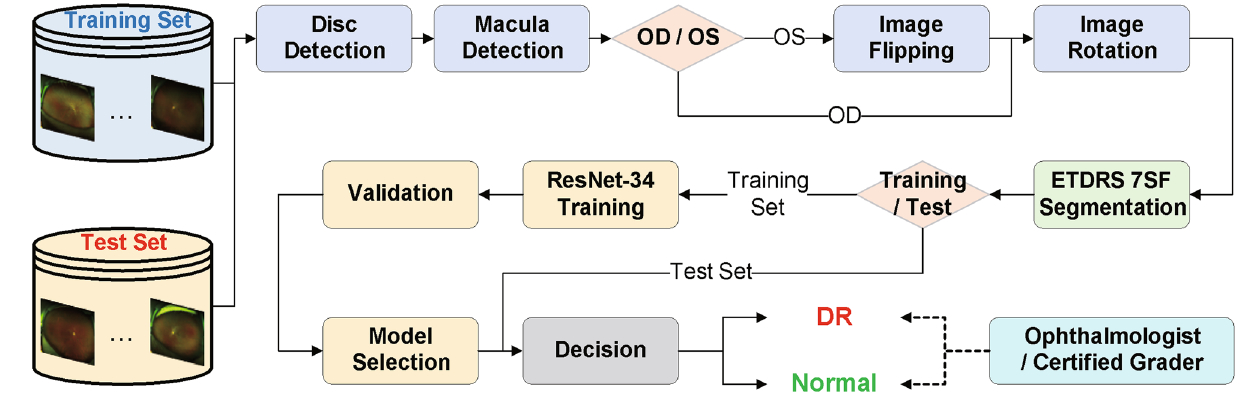
Figure 1. An overview of the proposed DR detection